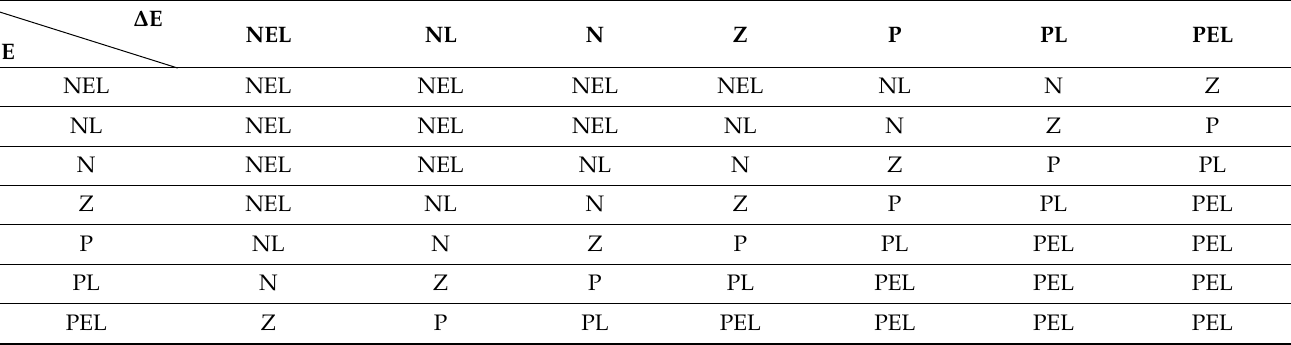
Table 1. Fuzzy rule